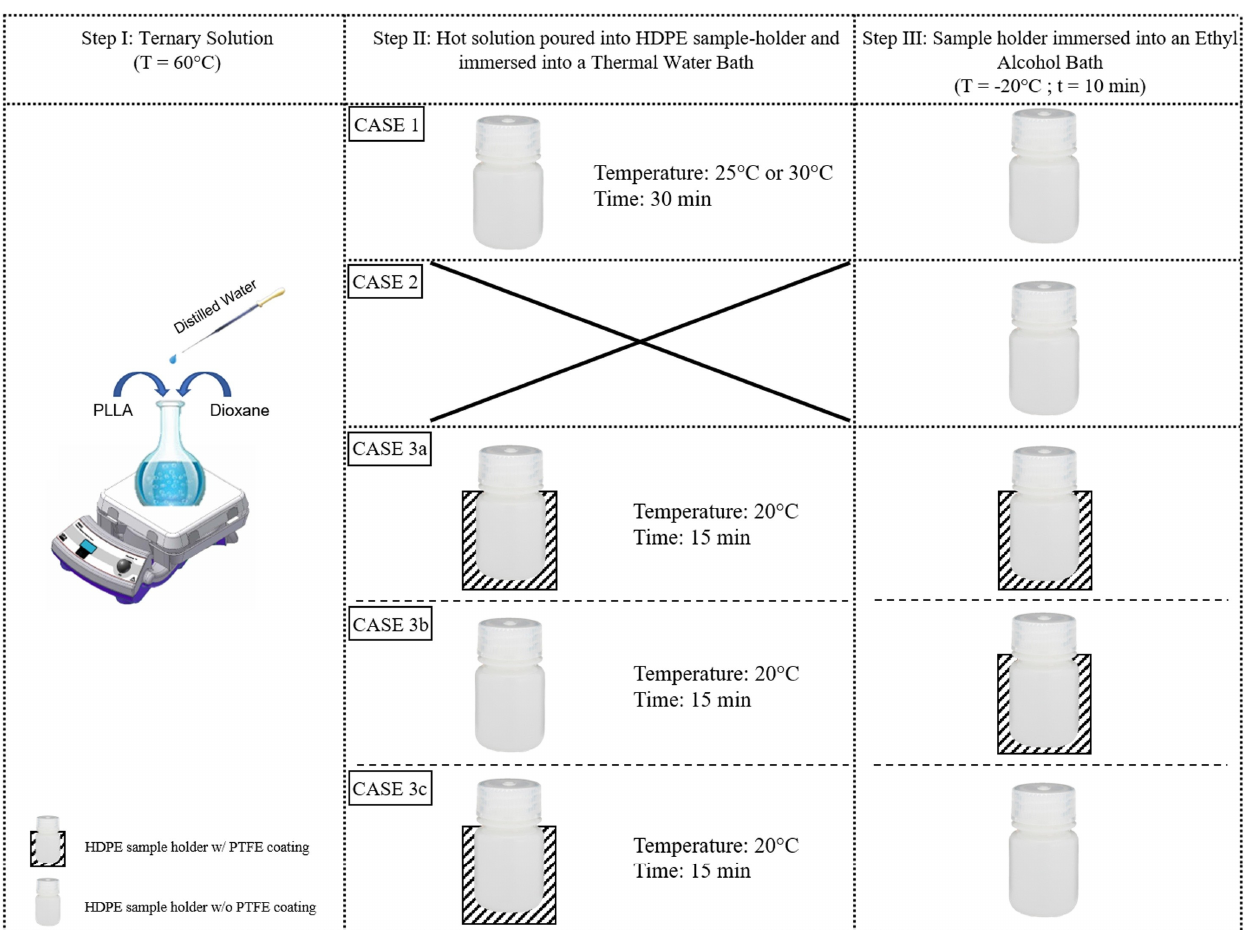
Figure 5. Schematic representation of scaffold preparation steps. A ternary solution (PLLA/dioxane/water) was prepared and kept at T = 60 ◦ C, and hot poured into HDPE cylindrical sample-holders. Case 1: the sample holder was maintained at the demixing temperature of 25 ◦ C (or 30 ◦ C) for 30 min; thereafter, the system was suddenly quenched by pool immersion in an ethyl alcohol bath (EAB) at a temperature of − 20 ◦ C for at least 10min to freeze the as-obtained structure. Case 2: the sample-holder was placed directly at − 20 ◦ C for 20min being subjected to the so-called Direct Quench (DQ). Case 3 a,b,c: the sample holder was kept uncoated or embedded in a PTFE coating before immersion in the thermostatic water bath (TWB) and then maintained at the demixing temperature of 20 ◦ C for 15 min; thereafter, the system was suddenly quenched by pool immersion in an ethyl alcohol bath (EAB) or at a temperature of − 20 ◦ C for at least 10min to freeze the as-obtained structure